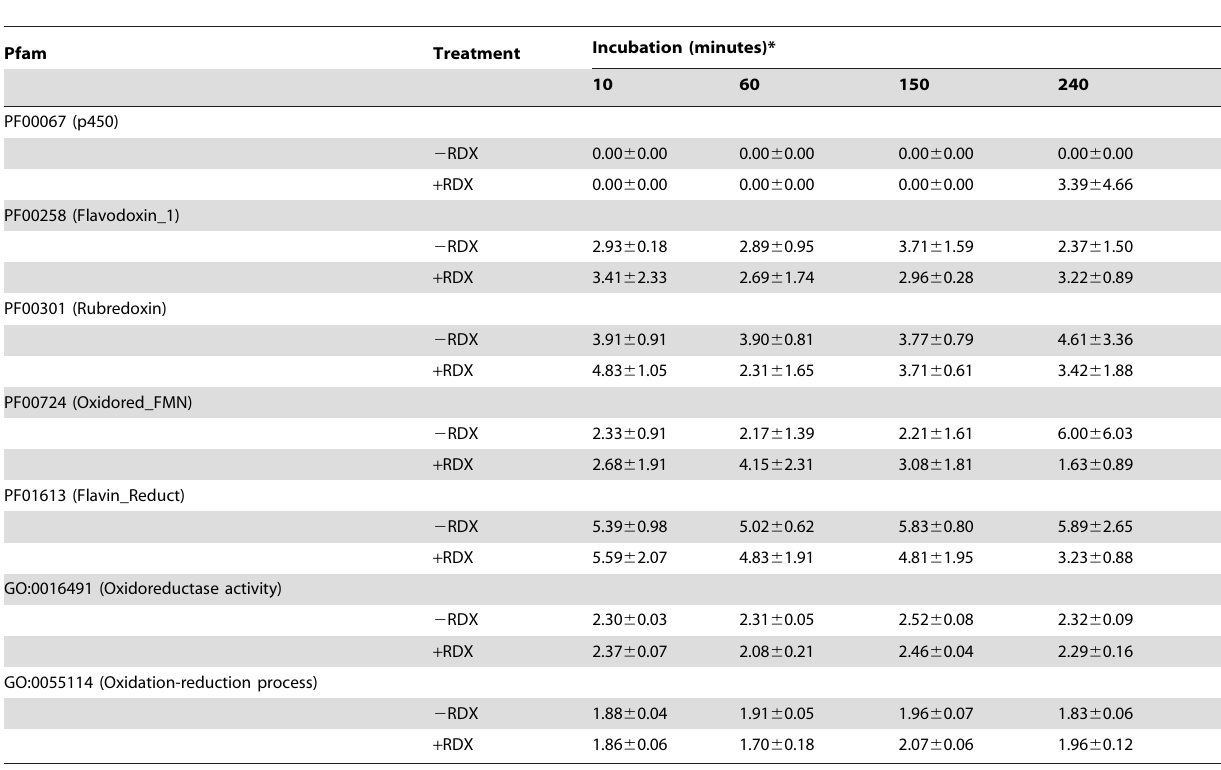
Table 2. The relative abundance of Pfam protein families and Gene Ontology (GO) involved in RDX degradation remained unchanged in the ovine rumen microbiome during RDX